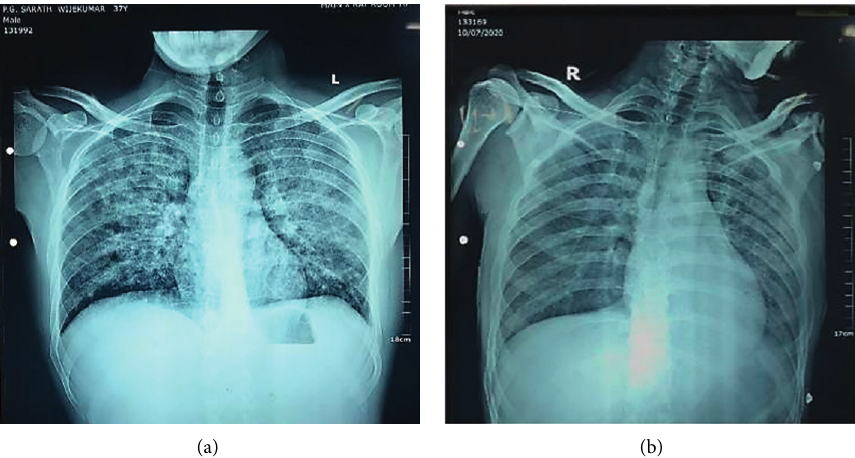
Figure 2: (a) CXR-PA taken on day 3 of illness (showing widespread opacities in both lung fields) and (b) on day 5 of illness